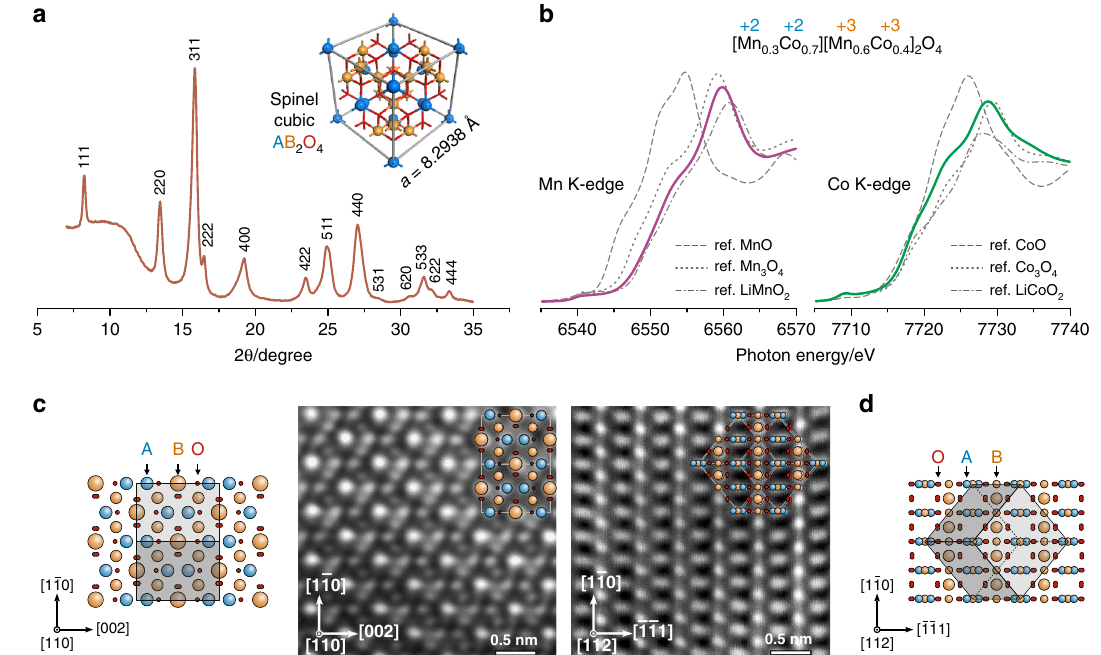
Fig. 2 Structural characterizations of the Mn-Co catalyst. a Synchrotron X-ray diffraction (XRD) pattern, identifying the spinel cubic crystal structure with a lattice constant a = 8.2938 Å (inset). X-ray wavelength λ = 0.68876 Å. The raised baseline at around 10 o is due to the carbon black support of the Mn-Co spinel (MCS). b X-ray absorption near-edge structure (XANES) spectra. The K-edge absorptions of Mn and Co were collected, each with three reference samples. The formal valences of Mn and Co were determined to be + 2.76 and + 2.56, respectively, corresponding to a stoichiometry of [Mn 0.3 Co 0.7 ] [Mn 0.6 Co 0.4 ] 2 O 4 . c , d High-angle annular dark- fi eld images from scanning transmission electron microscopy (HAADF-STEM) images of the MCS lattice, taken on zone axes of [110] and [112]. Models of lattice projection are provided, with a unit cell embedded in the picture, to interpret the atomic resolution images. See Supplementary Figs 8 and 9 for reasoning of the spot brightness. Elemental mapping results are provided in Supplementary Fig. 10 NATURE COMMUNICATIONS| (2019) 10:1506